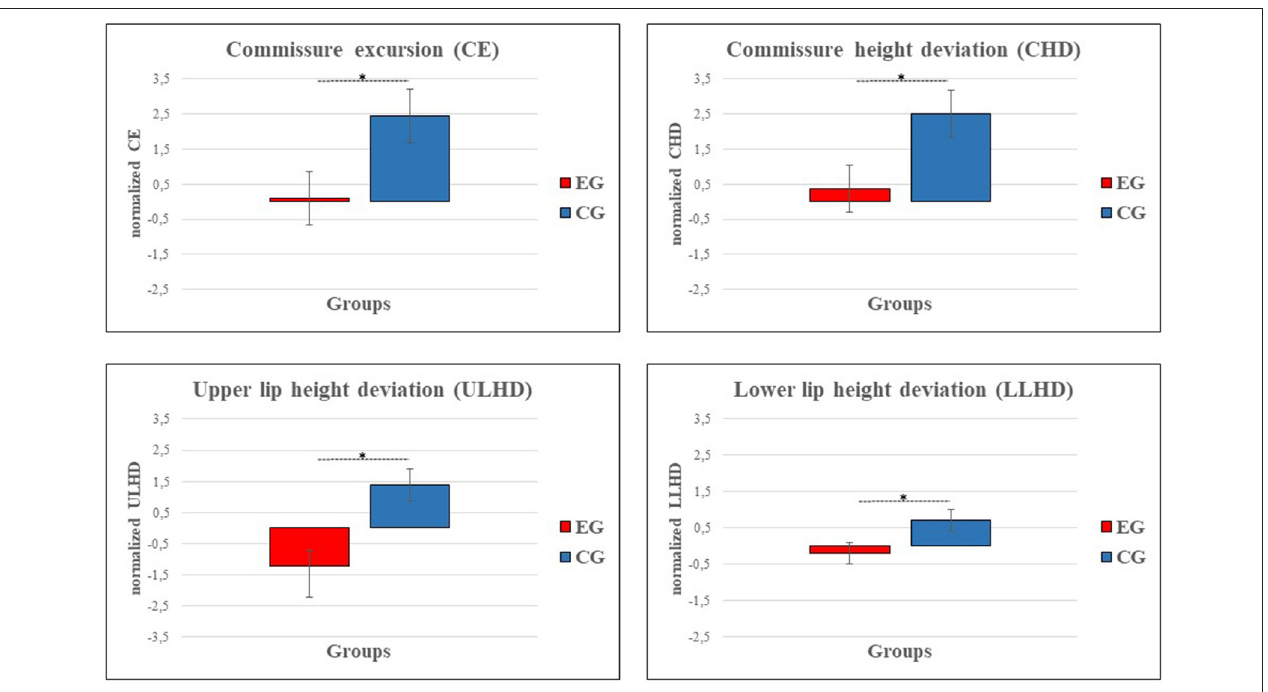
FIGURE 2 | Graphs show a reduction in asymmetry between experimental (EG, red) and control group (CG, blue) in the following Emotrics measurements: commissure excursion (CE), commissure height deviation (CHD) and upper/lower lip height deviation (LLUD, CE, CHD and LLHD are represented as the difference of gentle smile values with respect to static posture. ULHD results are represented as the difference of gentle smile and maximum smile values with respect to static posture. Error bars represent SE (standard errors of the